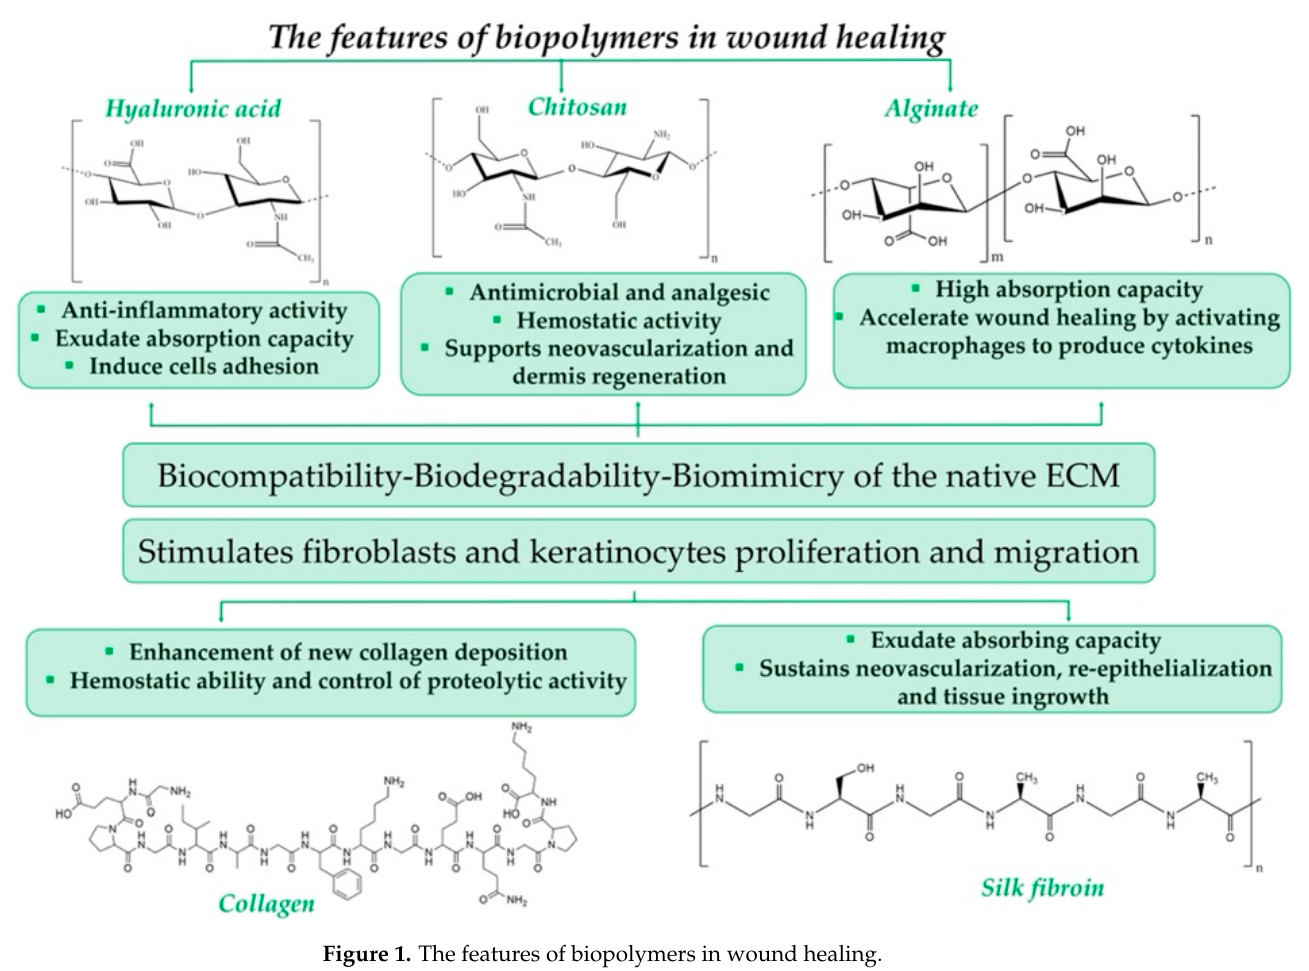
Figure 1. The features of biopolymers in wound healing.